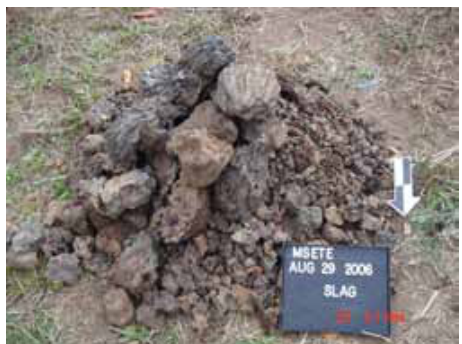
Fig 7: The smelting slags of the Mjimwema area.